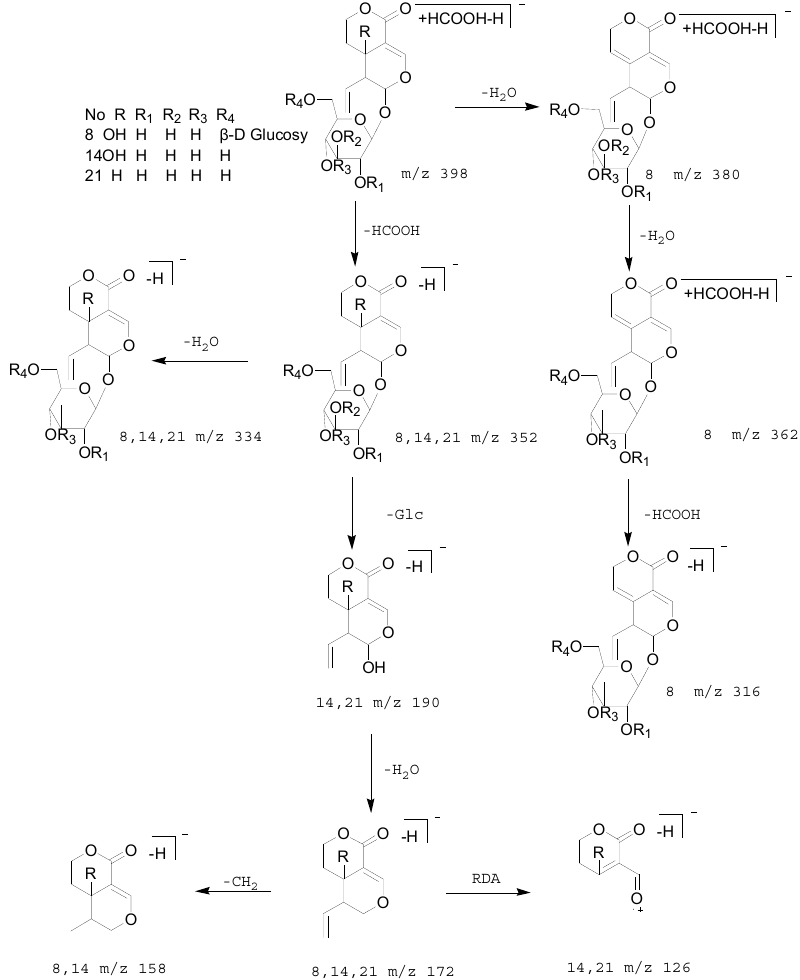
Figure 6. The proposed fragmentation pathway of 6 ′ - O - β - D -glucosyl swertiamarin, swertiamarin, sweroside.